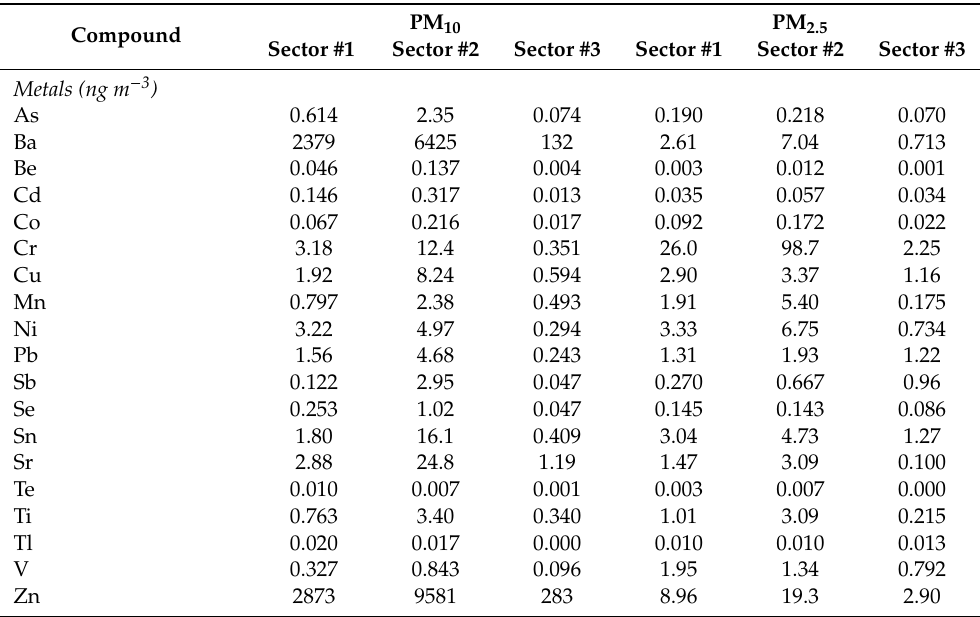
Table 3. Levels of Metals, PAHs, PCDD / Fs and PCBs determined at suburban area (Site